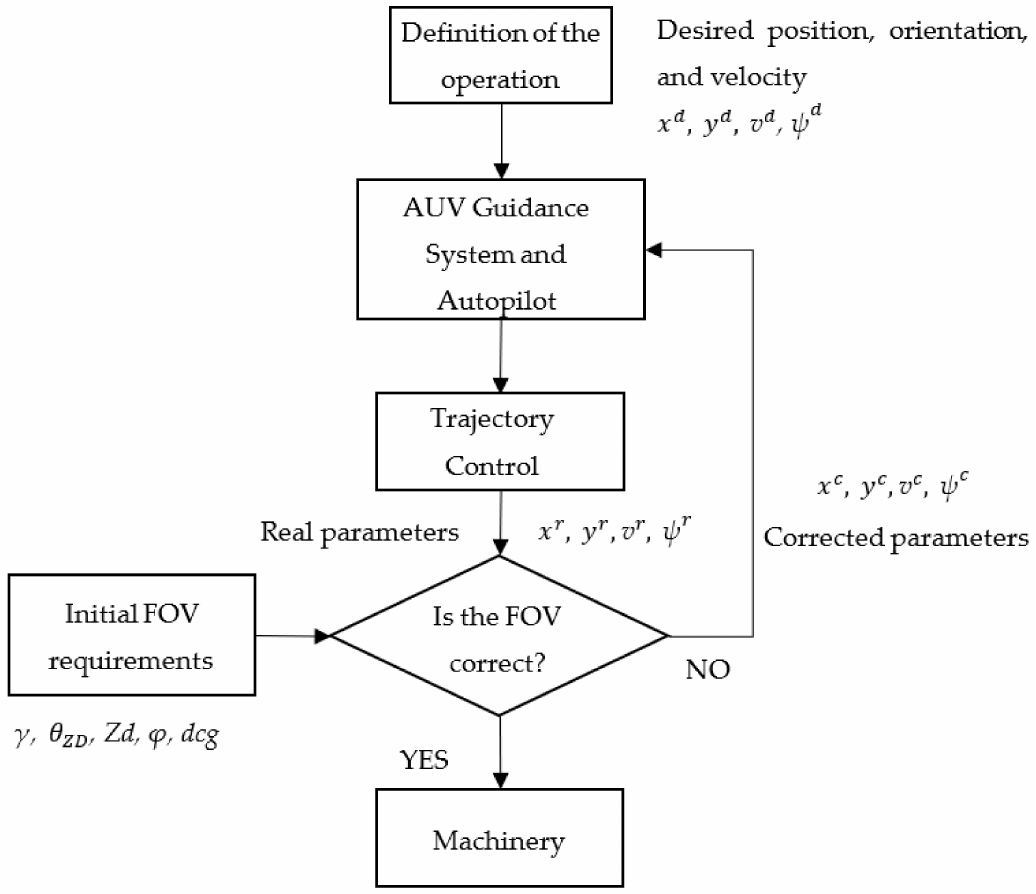
Figure 3. Diagram of the approach: AUV guidance system model including the FOV specifications.